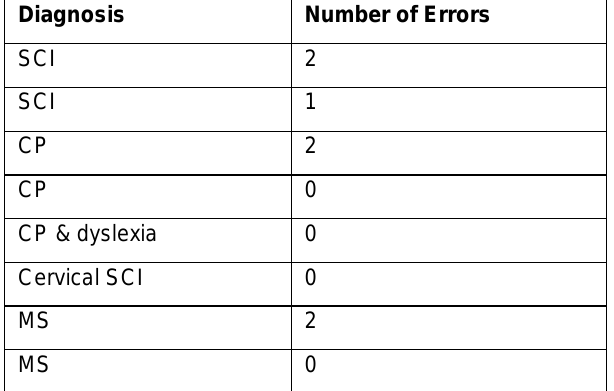
Table 3. Total Errors across All Tasks for Each Participant in the Final Round of App Usability